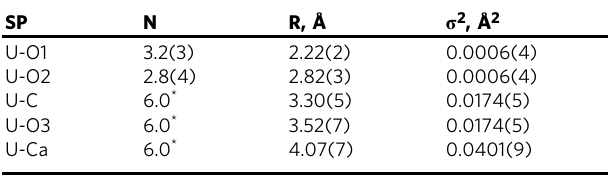
Table 1 EXAFS fi t results for the “ Äspö-calcite ” sample.